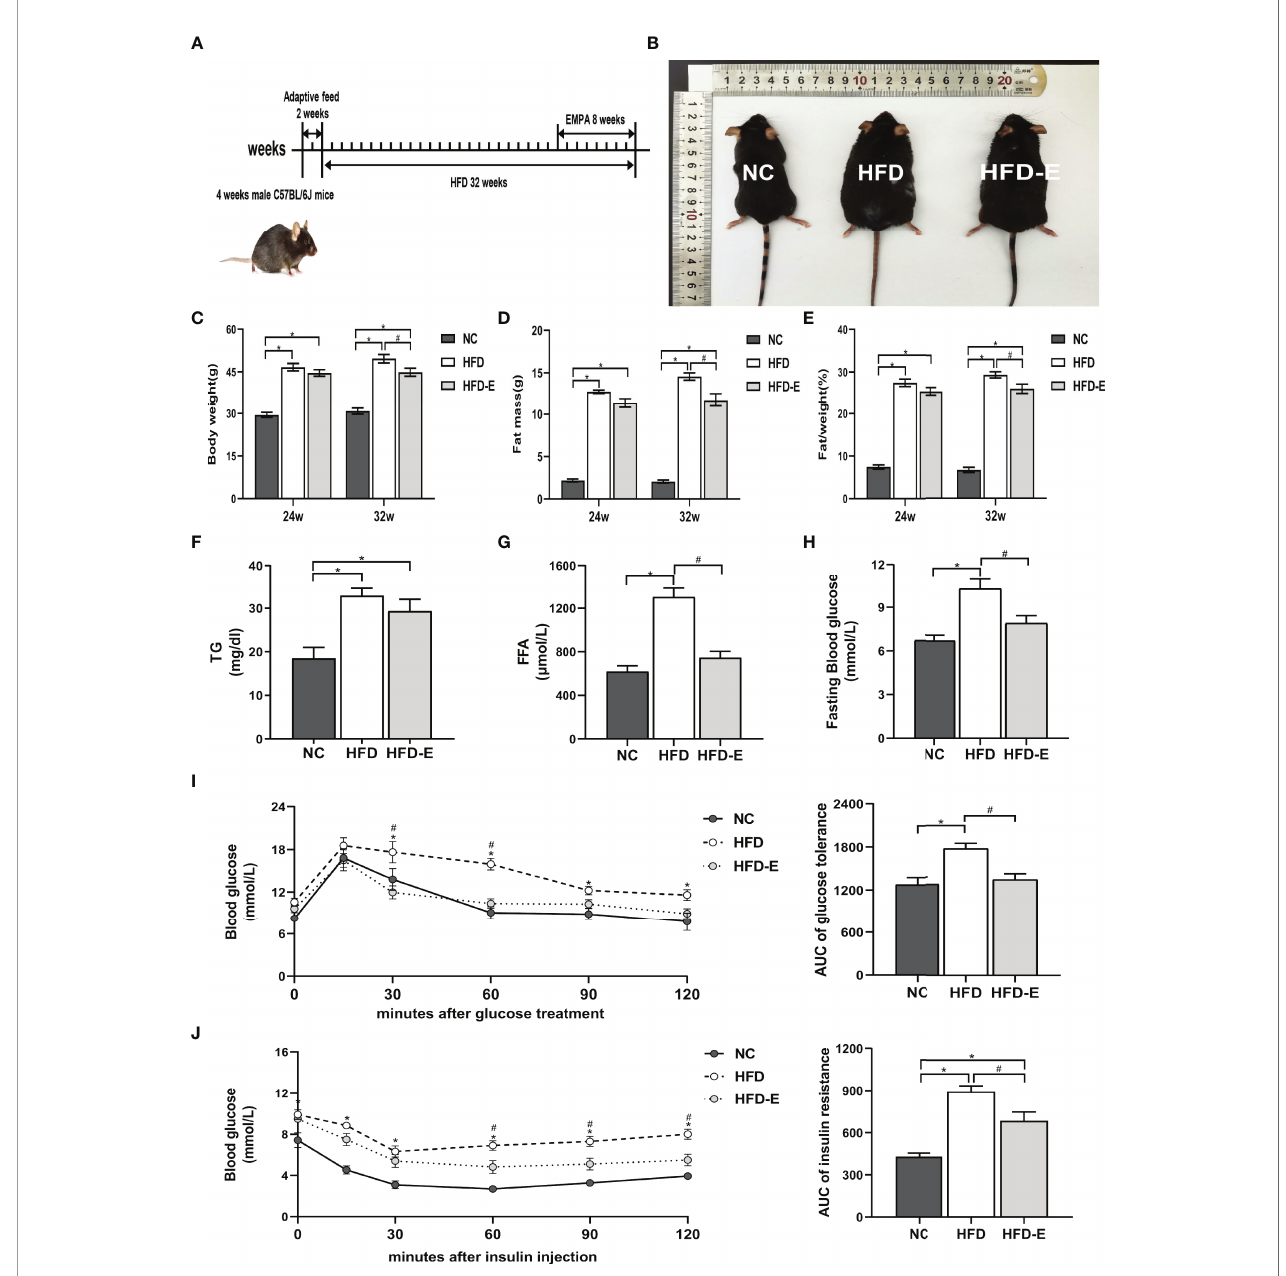
FIGURE 1 | EMPA reduced body weight and glycolipid metabolism. (A) 4-week-old male mice were fed HFD for 24 weeks and then treated with EMPA for another 8 weeks. (B) Morphology of mice. (C) Body weight. (D) Body fat mass. (E) Body fat mass%. (F) TG levels. (G) FFA levels. (H) Fasting blood glucose levels. (I) Oral glucose tolerance test and area under curve (AUC) of glucose tolerance. (J) Insulin tolerance test and AUC of insulin tolerance. Data are means ± SEM, n = 6/group, *P < 0.05 vs. NC; # P < 0.05 vs.